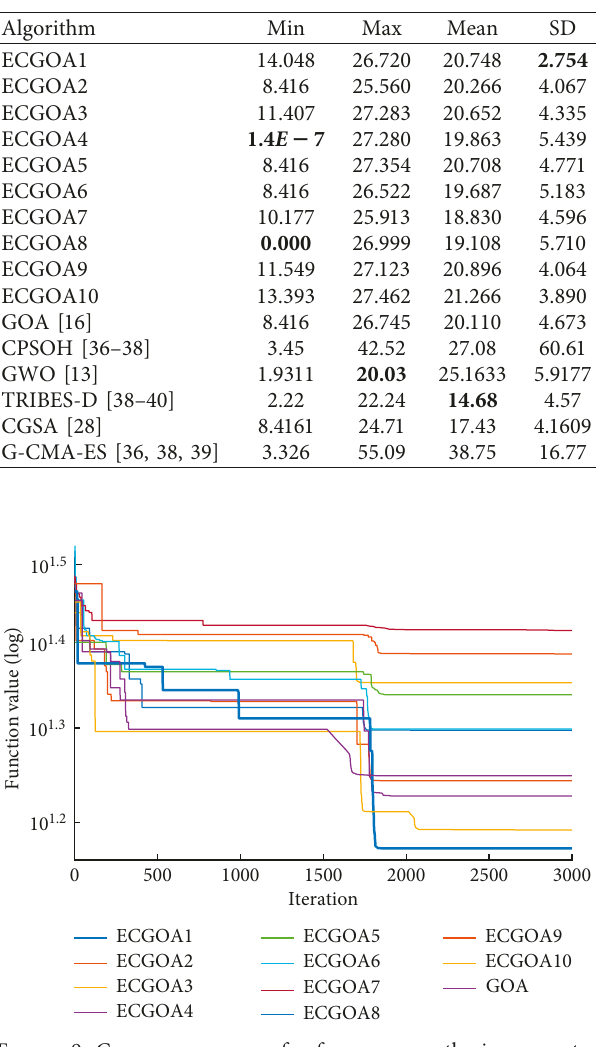
Figure 9: Convergence curve for frequency synthesis parameter estimation problem.